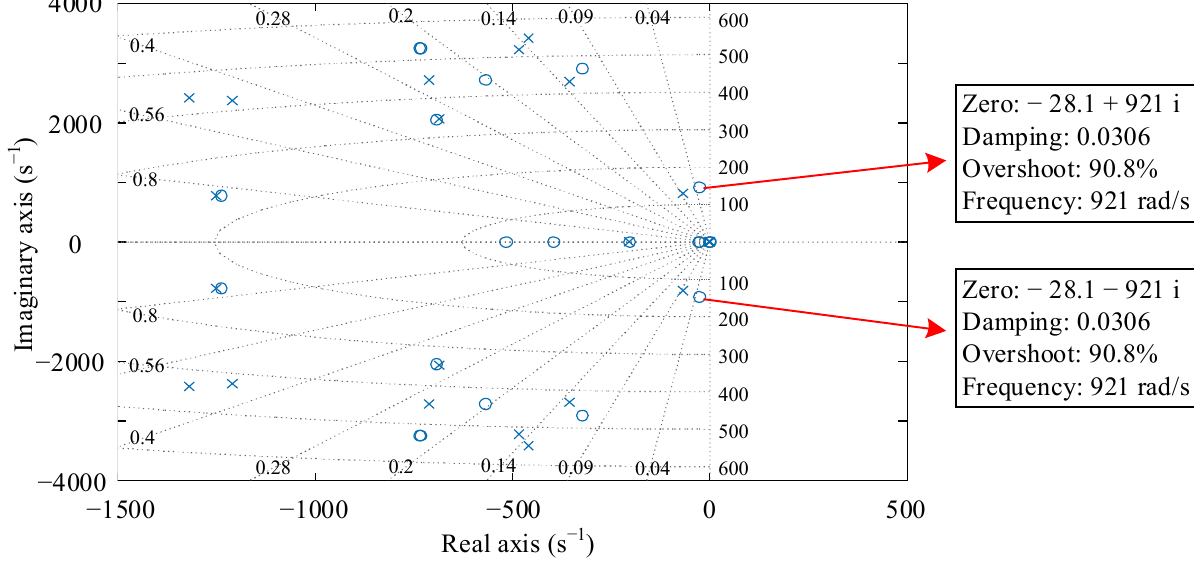
Figure 10. Pole-zero plot of the μ -controller. The bode diagram of the reduced order μ -controller of the channels from A end to A end and from B end to B end is given in Figure 11. At low frequency, due to the limita- tion of the weighting function W e , the controller has a good integration effect, which en- sures high static stiffness and good steady state accuracy. In the middle frequency band, the controller is similar to the PD controller, which has a good stabilizing effect on the rigid body mode of the rotor. At high frequency, the controller has a series of poles and zeros to stabilize the flexible mode of the rotor and rapidly obtain the gain decay.